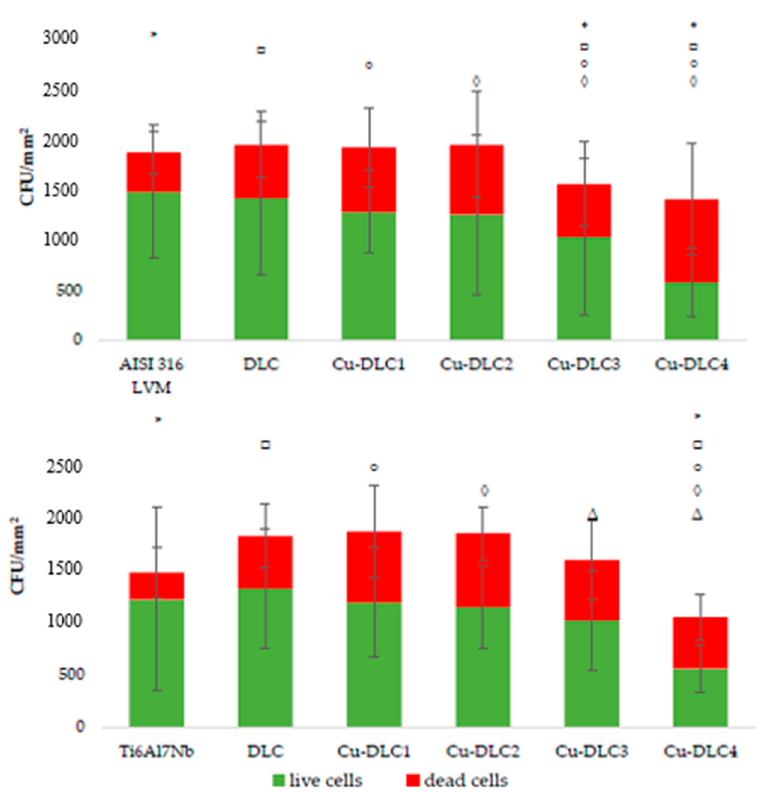
Figure 8. Assessment of microbial colonization of E. coli on Cu-DLC coatings deposited on AISI 316LVM ( top ) and Ti6Al7Nb ( bottom ).